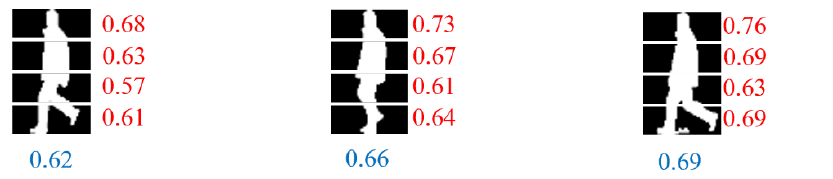
Figure 7. Importance scores for frames. The red words are the importance score of each part, and the blue words are the importance score of each frame.